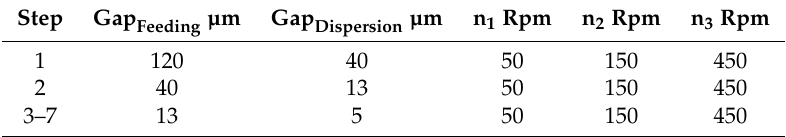
Table 1. Adapted process parameters for dispersion with three-roll-mill adapted from